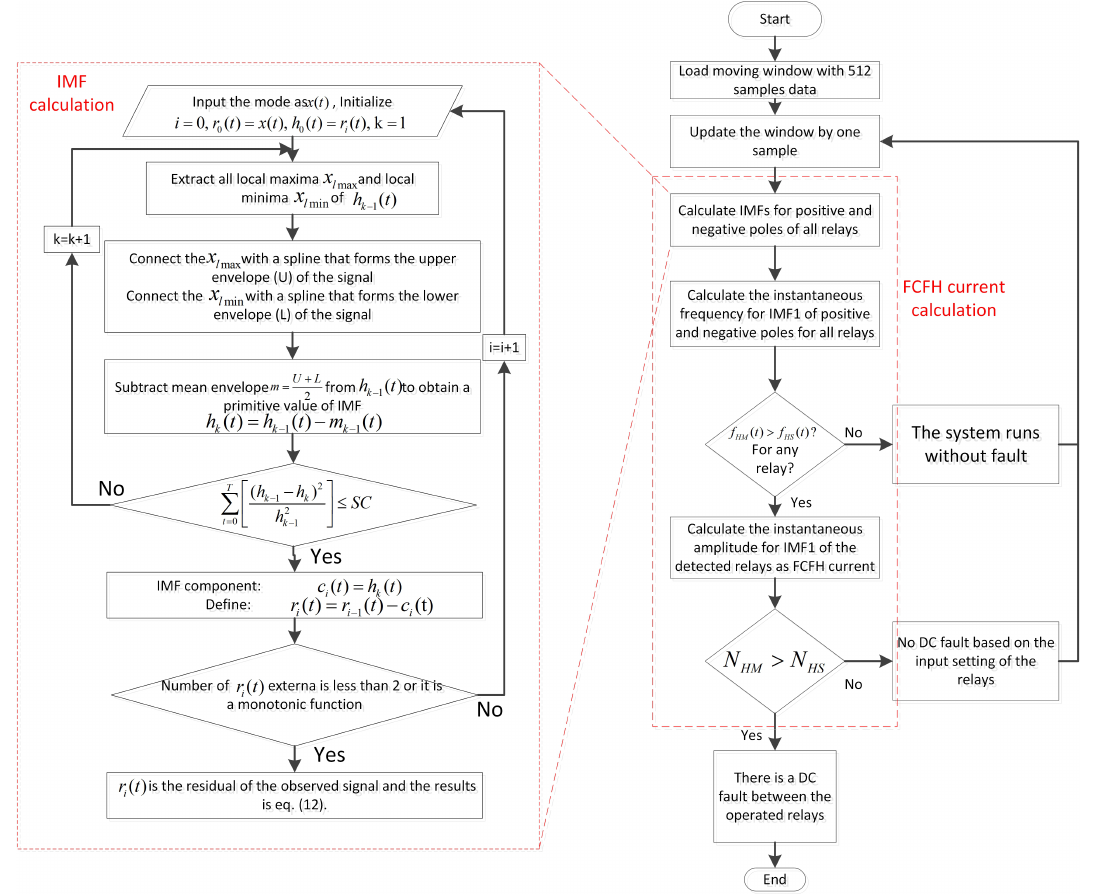
Figure 3. Flowchart of the proposed harmonic-based pilot protection